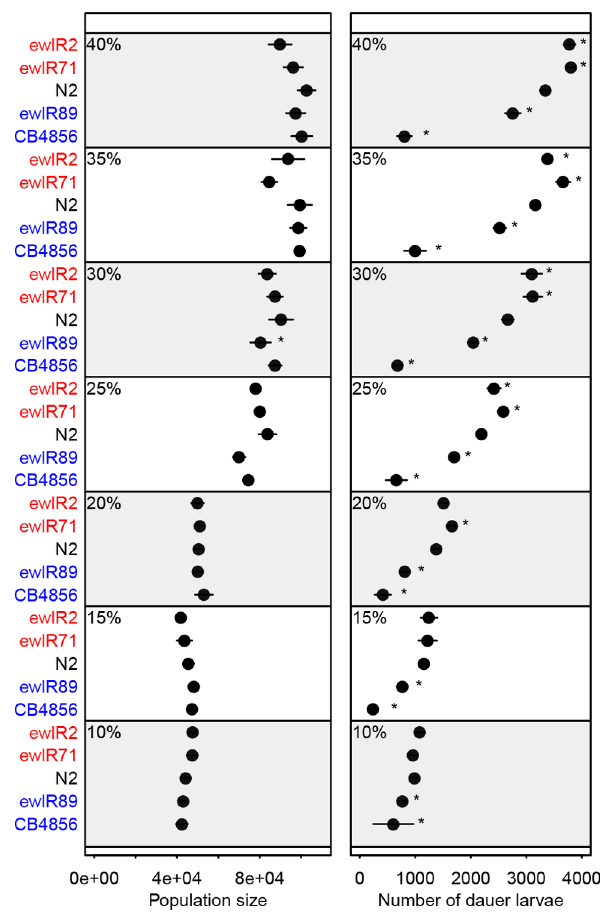
Figure 1. Food patch size affects the ability to detect QTLs and estimates of effect size. The mean population size (A) and number of dauer larvae (B) at exhaustion of 100 m l of a range of % w/v food patches for N2, ILs containing positive (ewlR2 and 71) and negative (ewlR89) effect QTLs and CB4856. Error bars indicate 6 1 S.E. and asterisks indicate significant difference to N2 at that food concentration ( p , 0.05, post hoc testing by Fisher’s Least Significant Difference for population size and Mann-Whitney U-test for the number of dauer larvae).